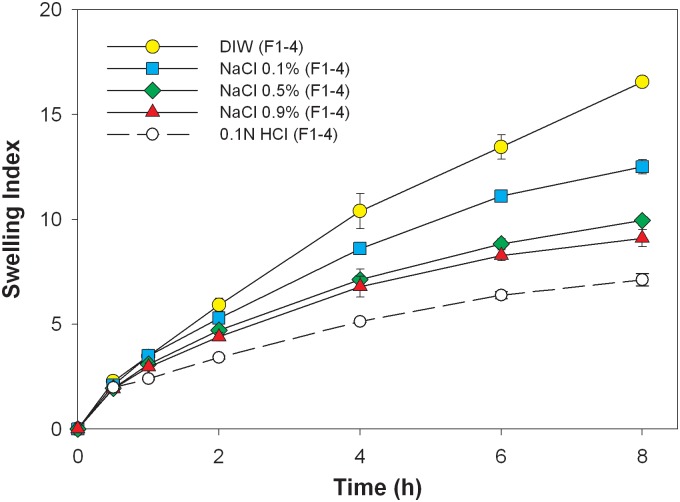
Swelling indexes of F1–4 in mediums with different concentration of NaCl.